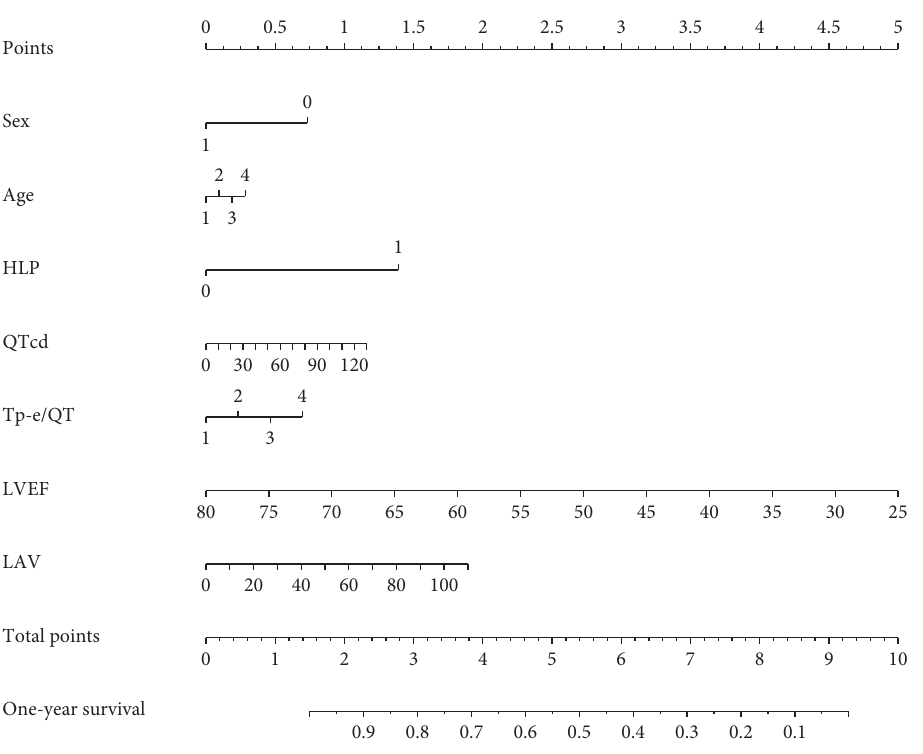
Figure 5: Nomogram for predicting the overall risk of non-VA in 1 year. Table 5: Comparison of risk factors between model group and verification